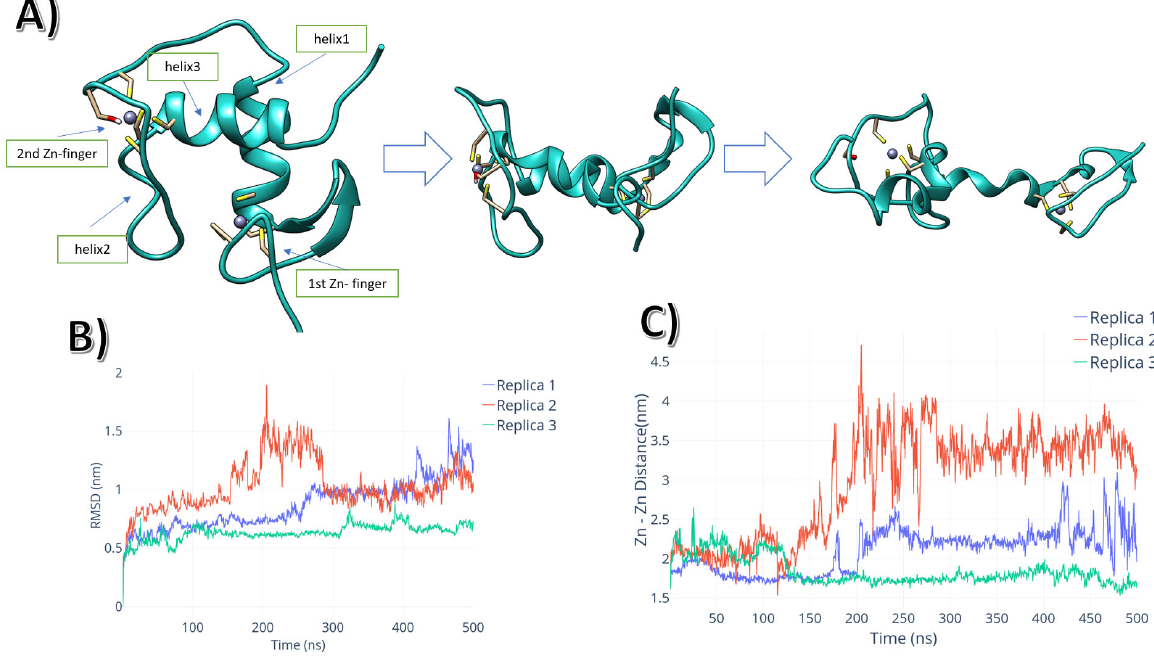
Figure 1. ( A ) AR ‐ DBD monomer unfolding pathway. ( B ) RMSD plot for each of the monomer Figure 1. ( A ) AR-DBD monomer unfolding pathway. ( B ) RMSD plot for each of the monomer replicas vs. time. ( C ) Inter Zn2+ distance vs. time. replicas vs. time. ( C ) Inter Zn 2+ distance vs.